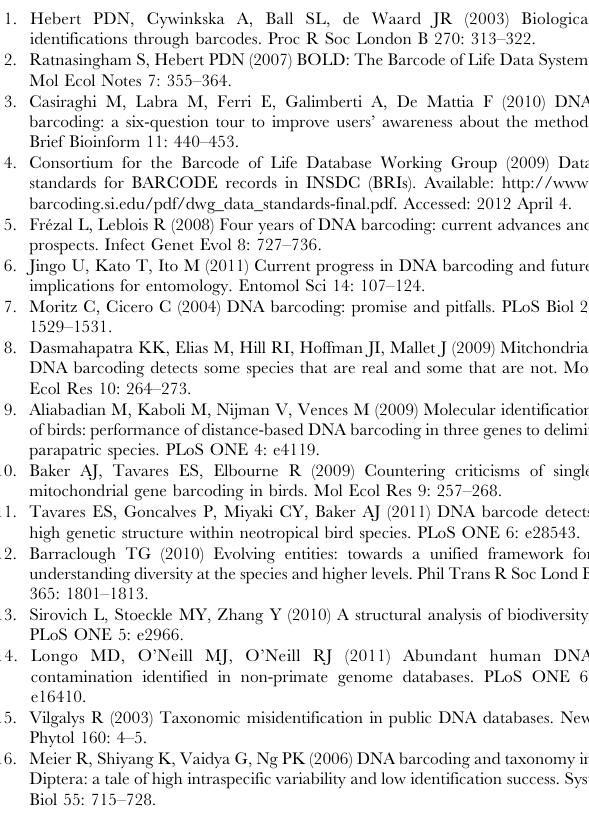
distant from the N. ornata BARCODEs with six VLFs. (TIF) Figure S3 Corvus frugilegus BARCODE EF515782 is a pseudogene. A) K2P NJ Tree for all GenBank C. frugilegus COI sequences, with BARCODE EF515782 highlighted in yellow and number of aaVLFs in parentheses. B) Trace files for C. frugilegus BARCODE EF515782 showing double peaks underlying VLF sites highlighted in yellow. (TIF) Dataset S1 Aligned nucleotide sequences of avian BARCODES in fas format. (FAS) Dataset S2 Nucleotide and amino acid frequency ma- trices and modal sequences generated from avian BARCODE dataset.